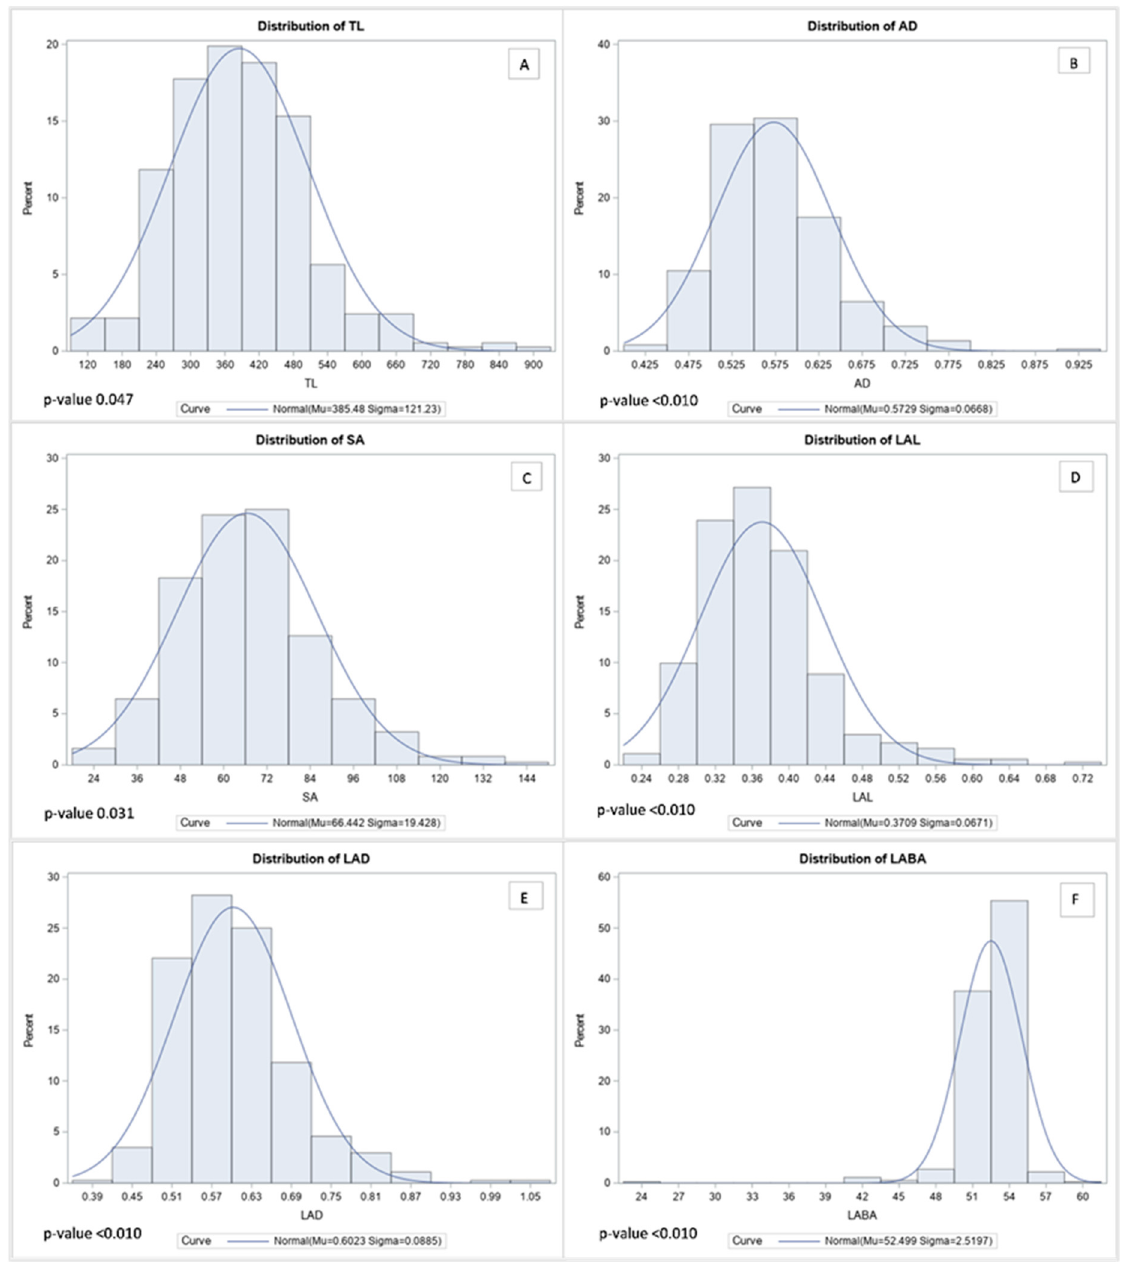
Figure 2. Histogram of normal distribution curves for root morphological traits. The Kolmogorov–Smirnov test was used for testing the normality of the distribution. In the figure, each abbreviation indicated total length (TL), average diameter (AD), surface area (SA), link average length (LAL), link average diameter (LAD), and link average branching angle (LABA), respectively. In the figure, each capital letters indicate distribution of root morphological traits such as TL (A), AD (B), SA (C), LAL (D), LAD (E), and LABA (F), respectively.